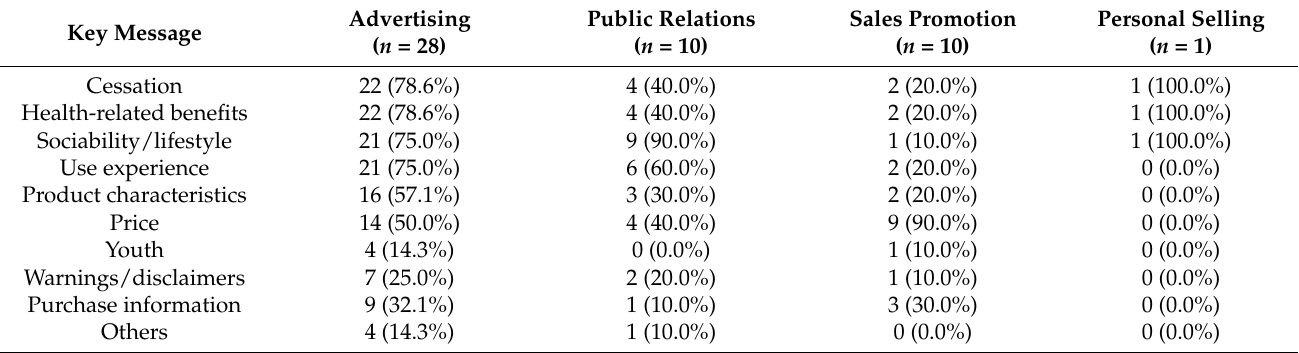
Table 3. Frequency of marketing communication messages across marketing communication strate- gies in published studies ( n = 36